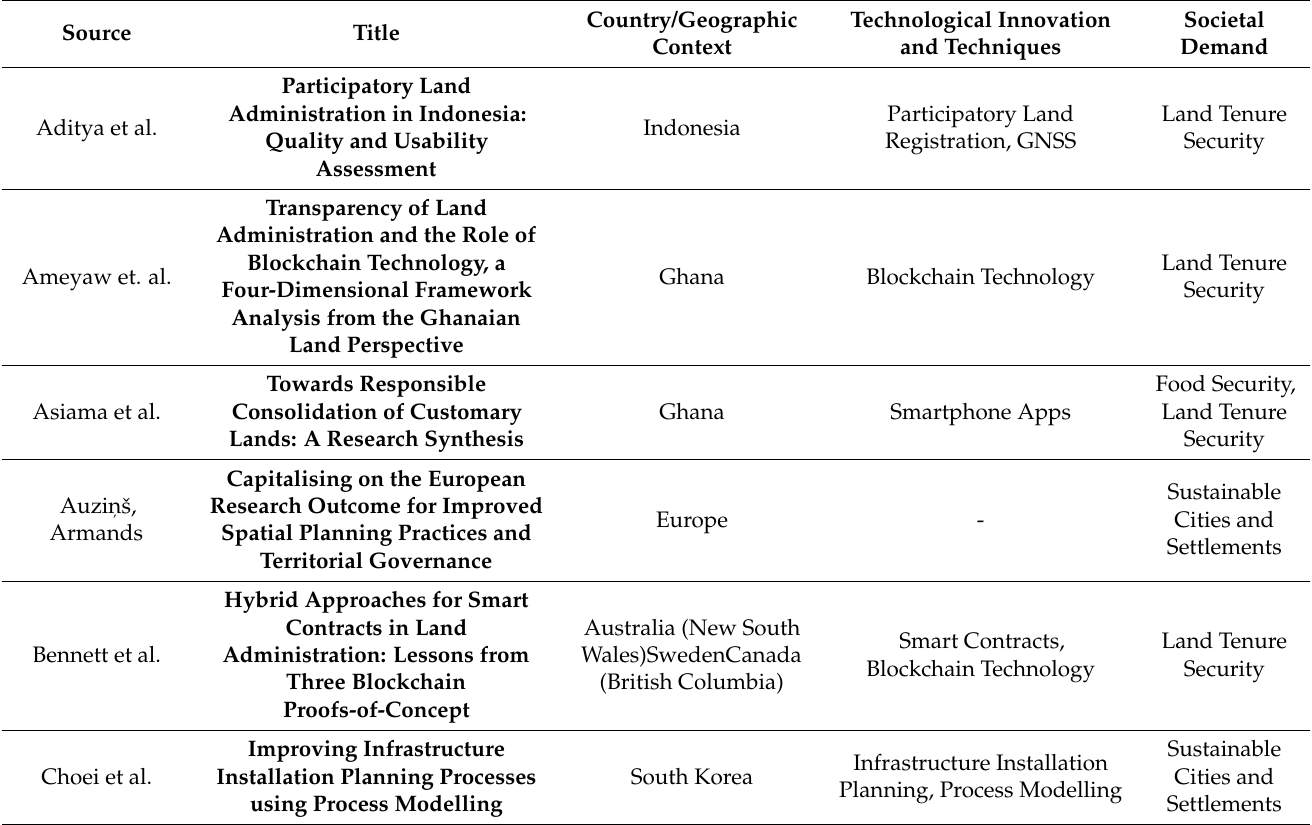
Table 1. Overview of the papers presented in the Special Issue.